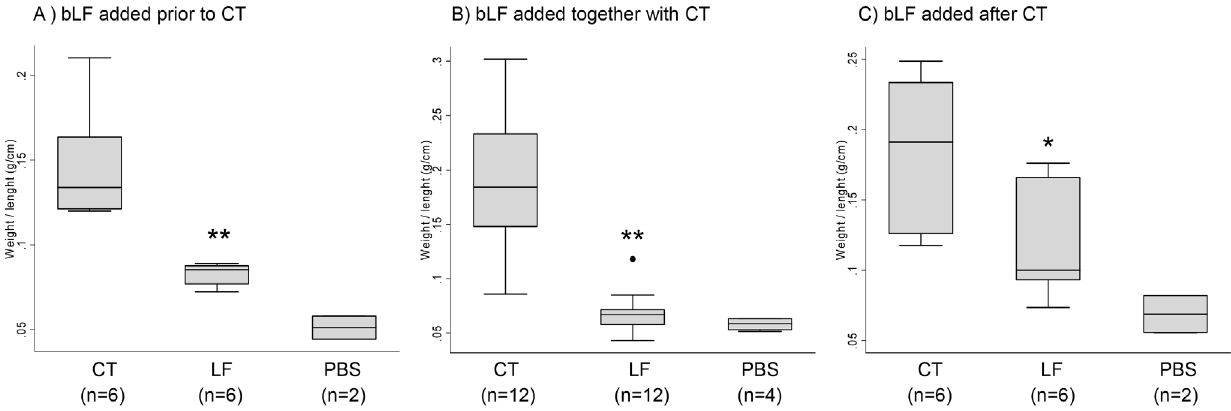
Figure 5. Effect of bovine lactoferrin (bLF) on CT-induced fluid accumulation in ileal loops. CT (1.5 m g) was added to the mouse ileal loop with bLF (10 mg/mL). Weigh/length ratios were calculated. A) bLF added before CT. Each loop was injected with 0.1 mL of sample solution (phosphate-buffered saline [PBS], 2 mg/loop bLF, PBS control) and 10 min later CT (1.5 m g) was added, B) bLF added together or at the same time with CT, and C) bLF added 10 min after CT. *, p , .05; **, p , .01 for the comparison of bLF group vs. CT groups, by Mann–Whitney U test.